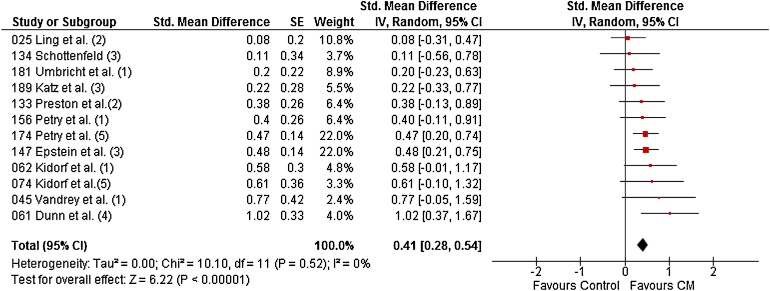
Forest plot for PNS during treatment of all substances combined. (1) = Cocaine, (2) = opiates, (3) = opiates and cocaine, (4) = Tobacco, (5) = Poly-substance.